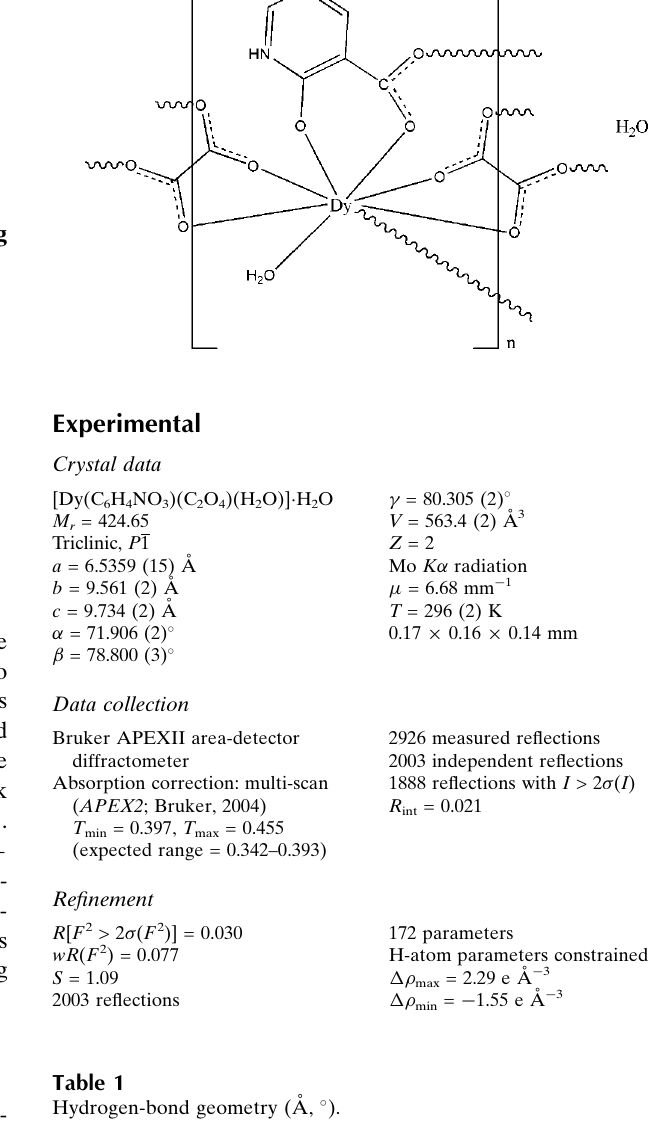
Hydrogen-bond geometry (A˚ , (cid:2)